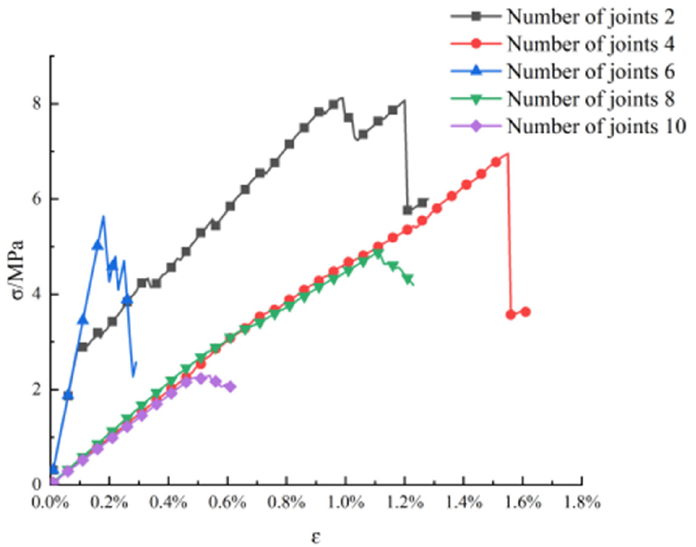
Figure 15. The stress–strain curve with different NPJs when joint angle is 45°.